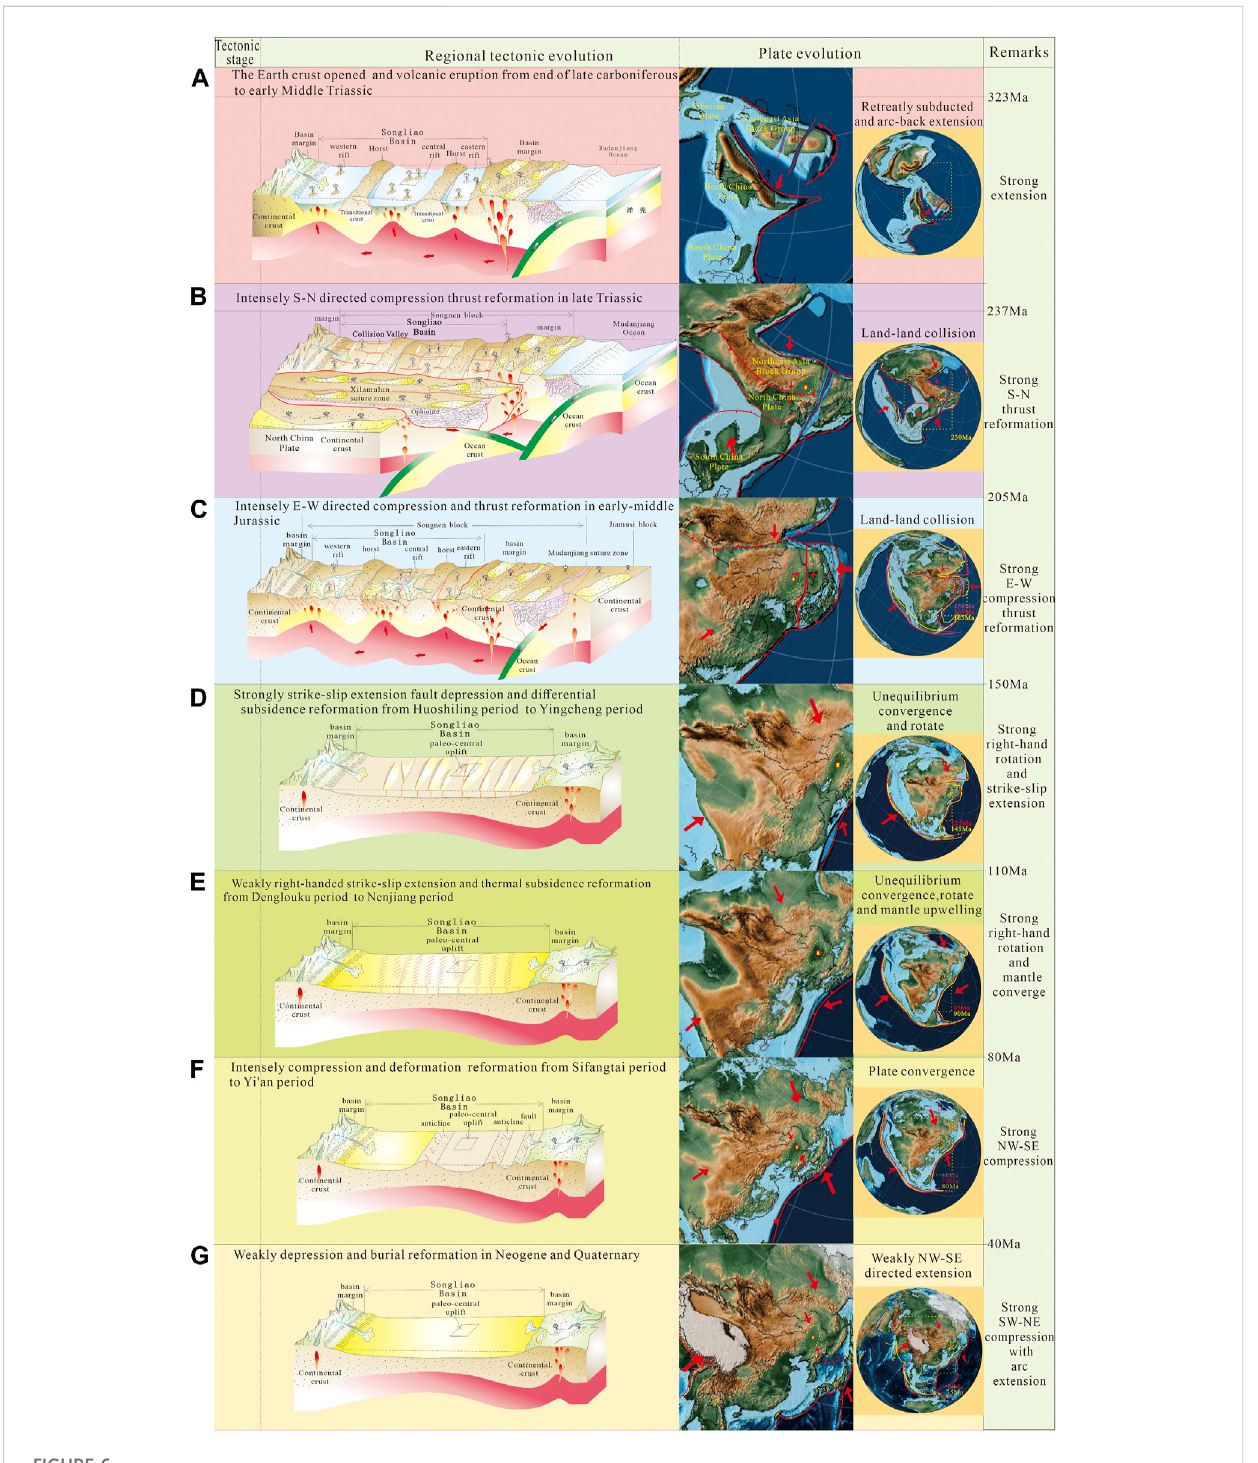
FIGURE 6 Schematic diagram of dynamic background of formation, evolution, and later transformation of Songliao Basin. Paleogeographic maps modi fi ed from Scotese